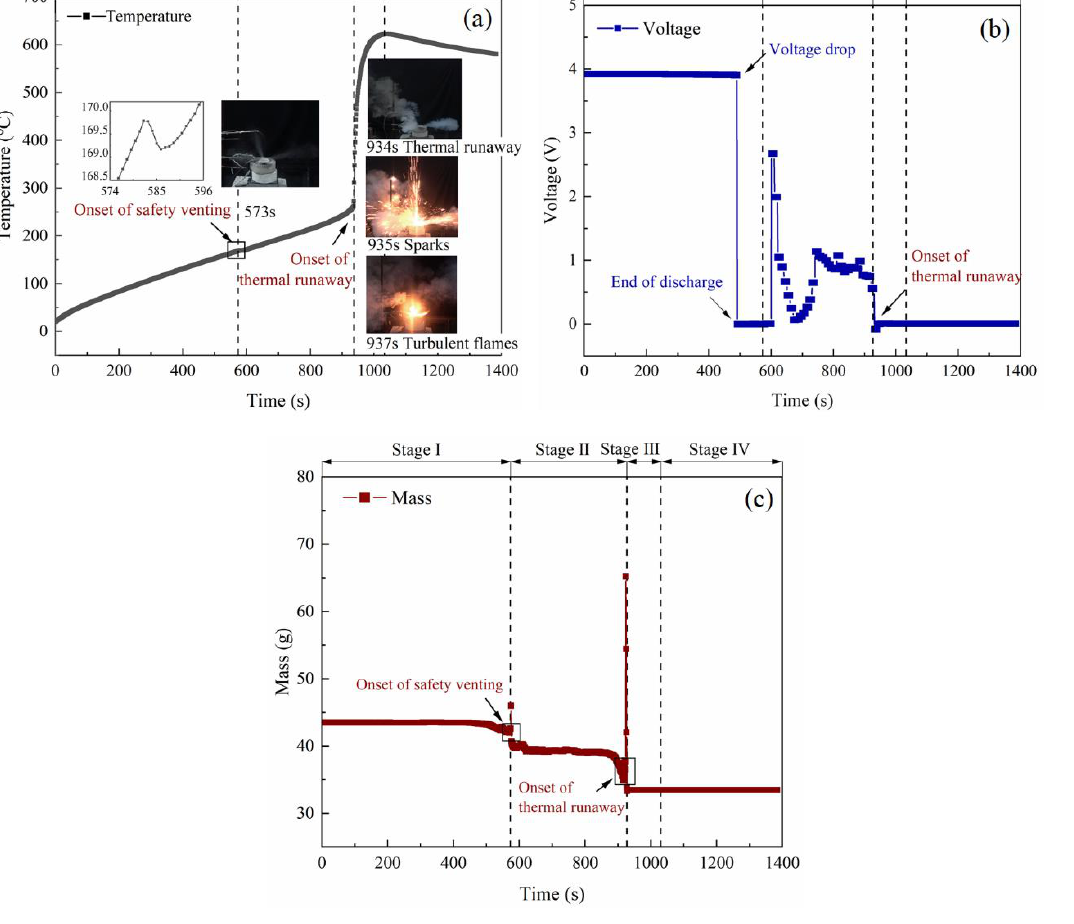
Figure 2. Test results from the battery during thermal runaway in an open circuit (Test 1). ( a ) The typical temperature curve and experimental phenomena. ( b ) The voltage characteristics across thermal runaway. ( c ) The representative mass history.